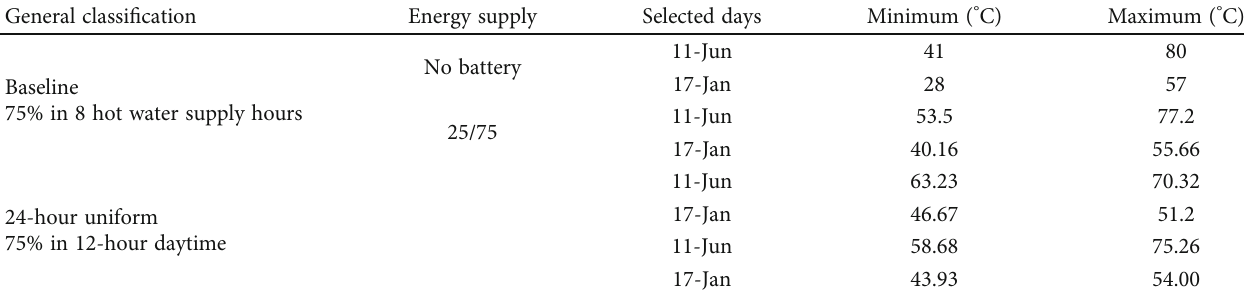
Table 6: Temperature of selected days in di ff erent energy supply cases.